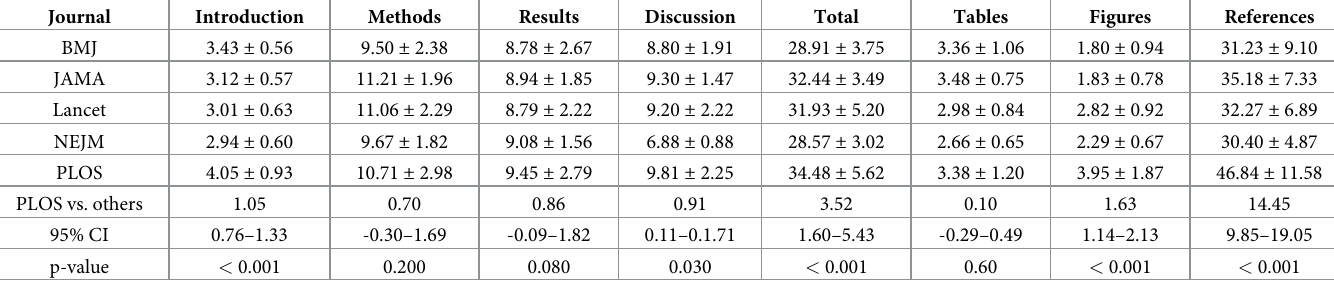
Table 3. Results of meta-analyses per journal over